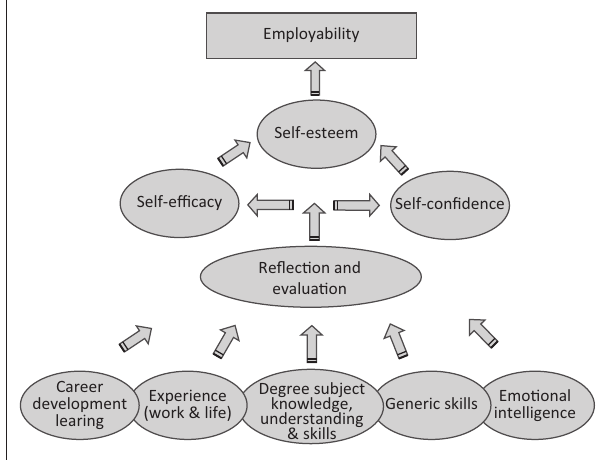
FIGURE 1: The CareerEDGE